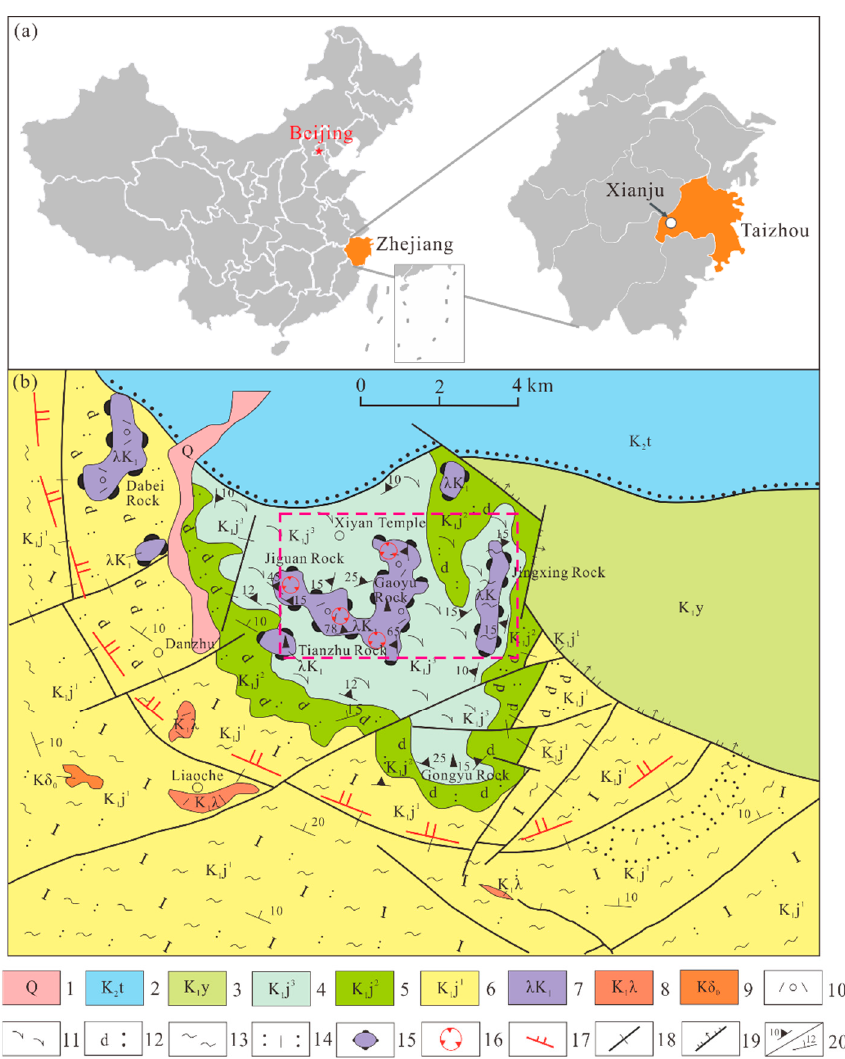
Figure 1. The location and geological map of the volcanic rock facies in the Shenxianju Scenic Area: ( a ) location of Xianju County; ( b ) geological map of the Shenxianju Scenic Area. The carmine-dotted rectangle marks the study area. 1. Quaternary, 2. Upper Cretaceous Tiantai Group; 3. Lower Cretaceous Yongkang Group; 4. third member of the Jiuliping Formation; 5. second member of the Jiuliping Formation; 6. first member of the Jiuliping Formation; 7. intrusive facies rhyolitic foam lava; 8. sub-rhyolite; 9. quartz diorite porphyrite; 10. rhyolitic foam lava; 11. overflow facies rhyolite; 12. Sedimentary tuff intercalated tuffaceous sandstone; 13. Pumice flow facies rhyolitic welded tuff; 15. invading dome; 16. volcanic conduit in the reactivation period; 17. boundary of the caldera; 18. volcanic fault; 19. regional fault; 20. flow surface/strata occurrence.